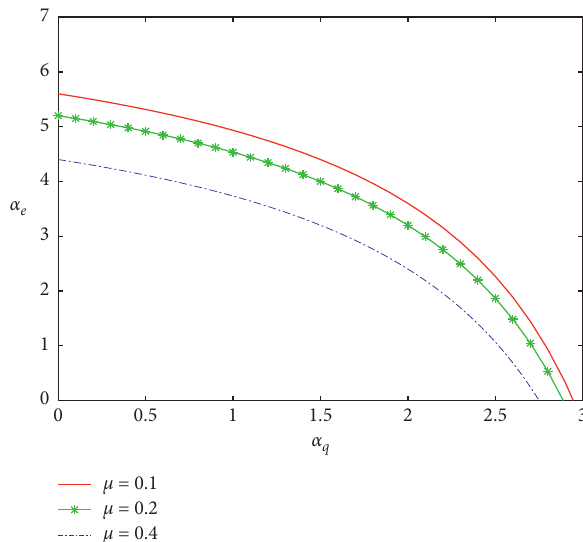
q and α e . Figure 2: The evolution process of dynamic system (25) with different parameter ( μ ) values.